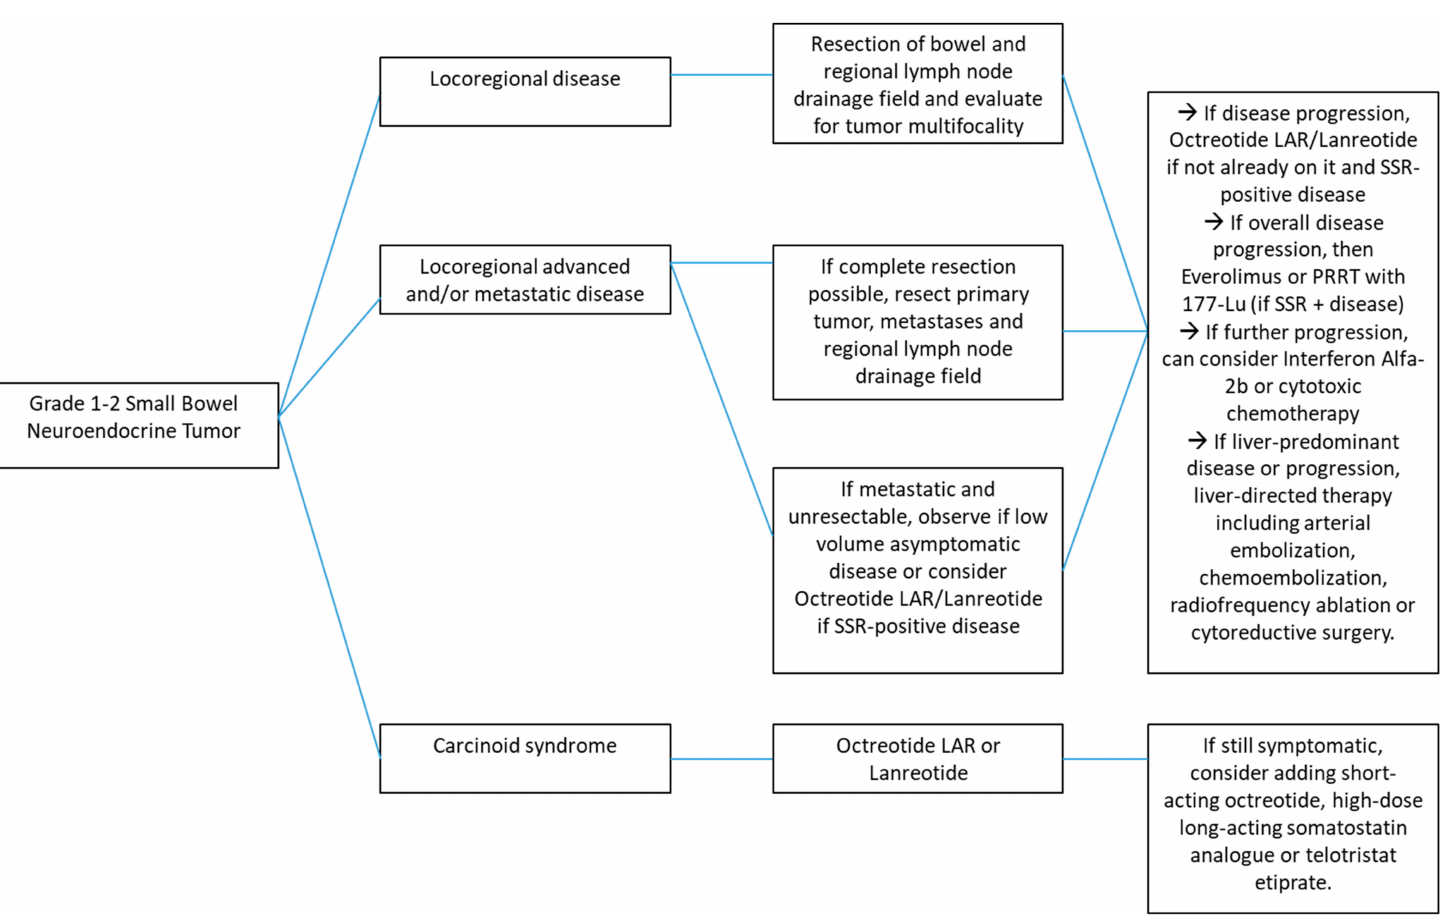
Figure 1. Management of Grade 1–2 Small Bowel Neuroendocrine Tumors—Flow